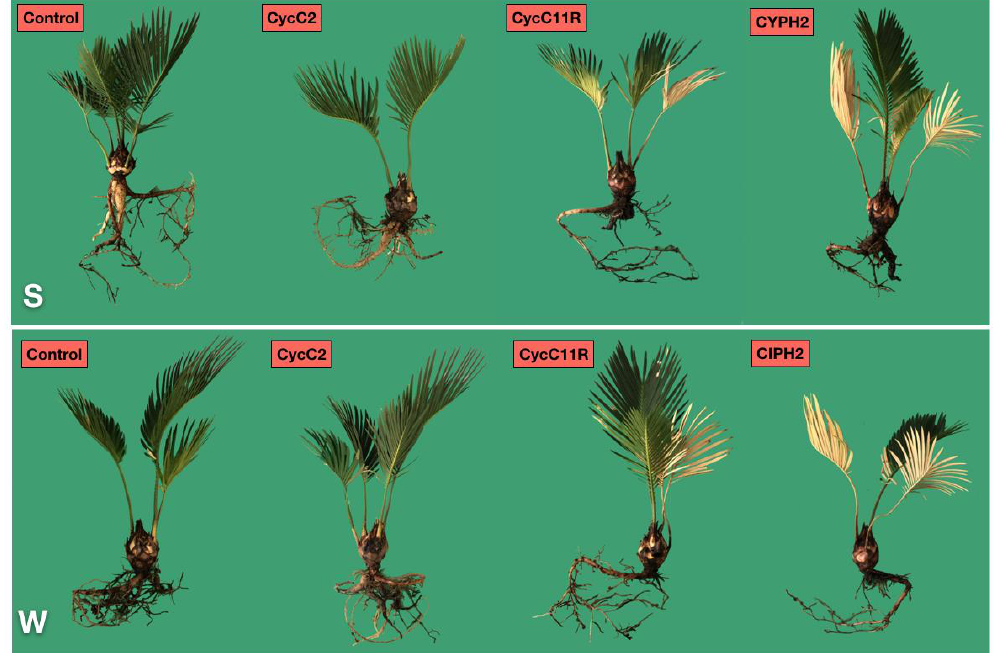
Figure 5. Symptoms of root rot and leaf chlorosis on Cycas revoluta plants, 2 months after transplant- ing from two separate experiments, soil-infestation (S) and wound-inoculation method (W) with Phytophthora pseudocryptogea (CIPH2) and P. nicotianae (CycC11R); no symptoms appear in the sago palm plants transplanted in both test with P. multivora (CycC2). Control plants remained asympto- matic in the two tests.